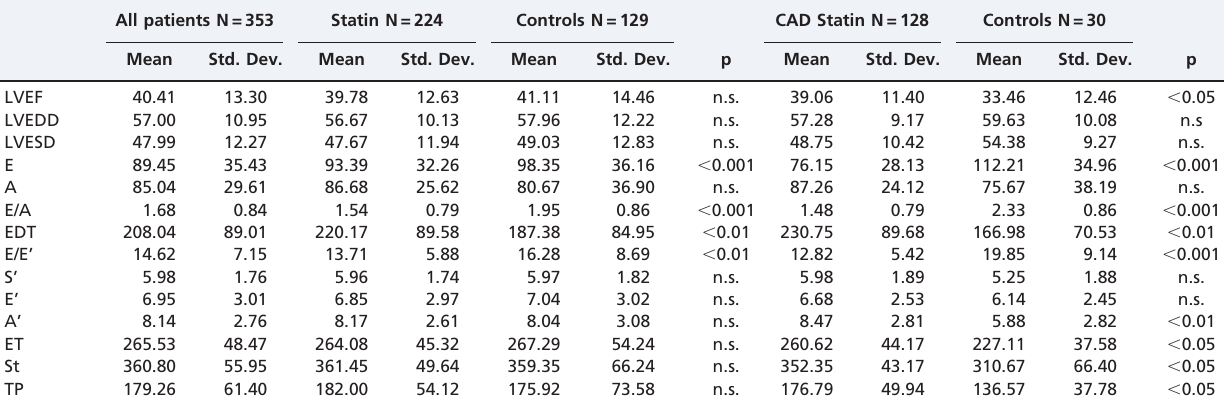
Table III - Echocardiographic characteristics. All patients N=353